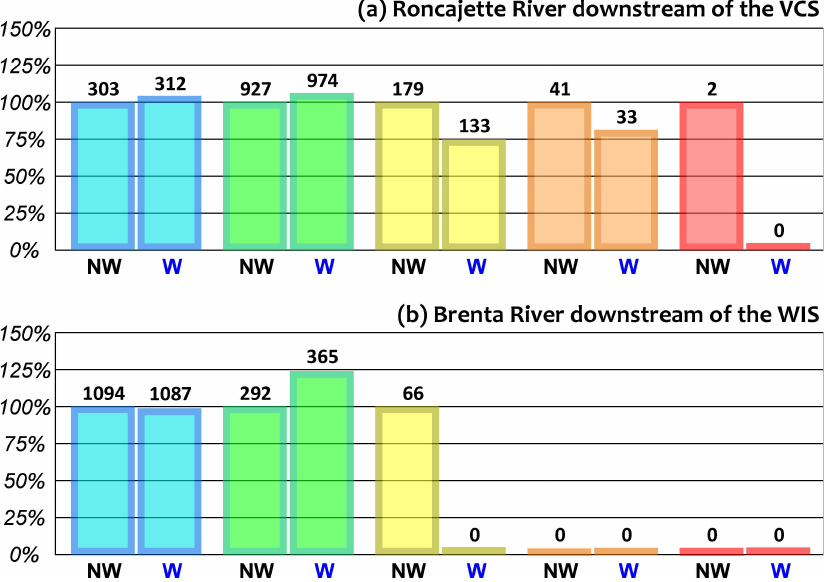
Figure 7. E ff ect of the waterway as a diversion canal on hydraulic risk in the Brenta–Bacchiglione river network. The number of hours (bold numbers) spent in each of the risk classes defined in Section 2.1.1, using (W) and without using (NW) the Waterway as diversion canal, for the Roncajette River ( a ) and for the Brenta River downstream of the WIS ( b ). Histogram bars are normalized with respect to the case of no waterway